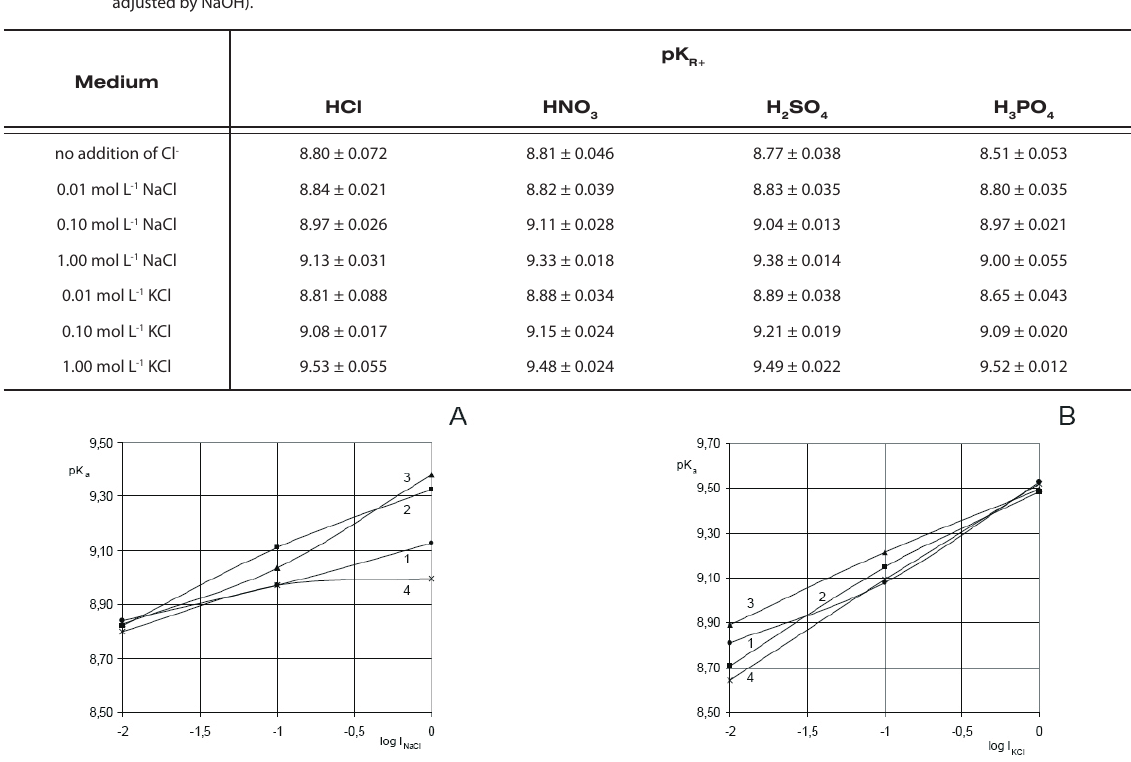
= 6.5 µmol L -1 , c = 0.01 mol L -1 mineral acid, pH CHE HA